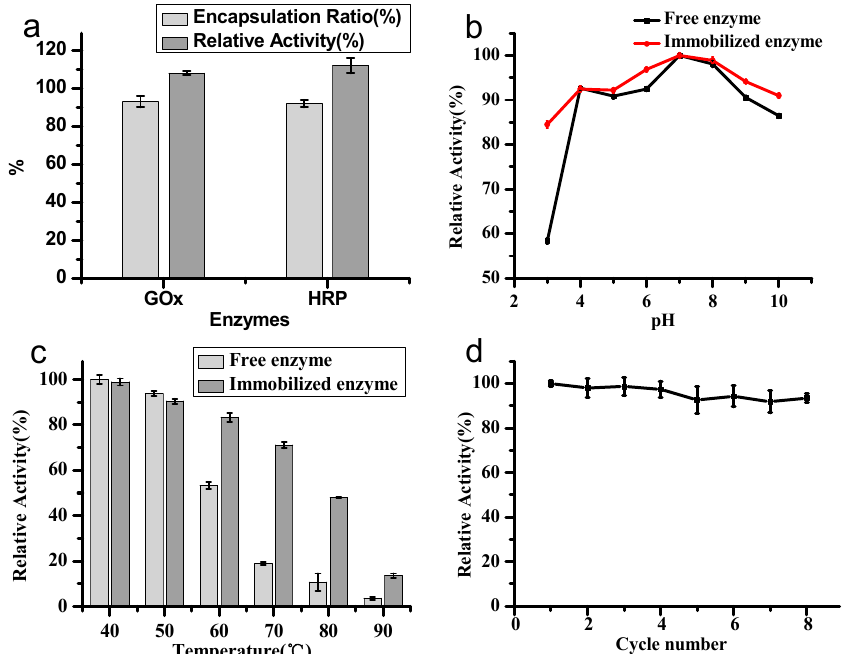
Figure 4. ( a ) Ratio of encapsulated glucose oxidase (GOx) and horseradish peroxidase (HRP) by the Zn/adenine complexes, and the relative activity of the two immobilized enzymes compared to the free enzymes; stability of the GOx–Zn/adenine complexes compared with the equivalent free enzymes ( b ) at different pH values at 25 ◦ C; ( c ) at different temperatures; ( d ) relative activity of GOx–Zn/adenine complexes after reusing for 8 cycles.